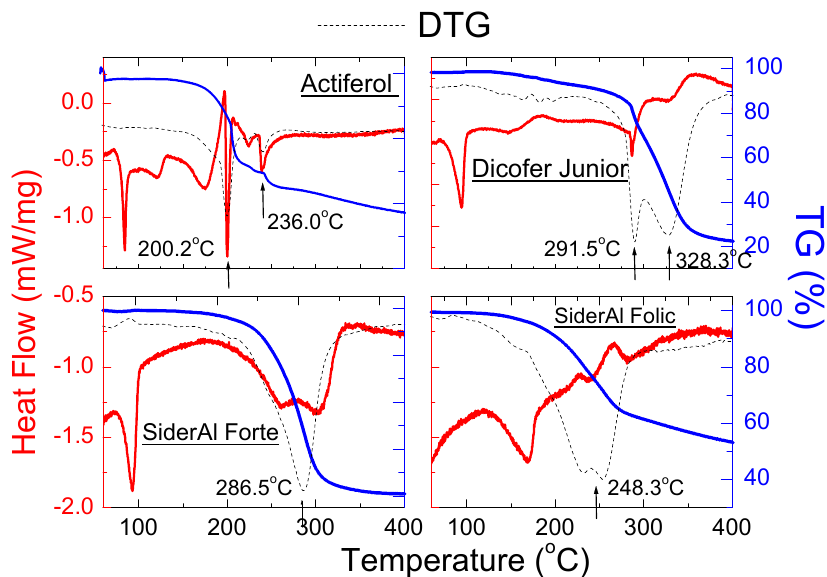
Figure 10. DSC and TG/DTG curves of dietary supplements containing iron (III) pyrophosphate: Actiferol , Dicofer Junior , SiderAl Folic and SiderAl Forte.